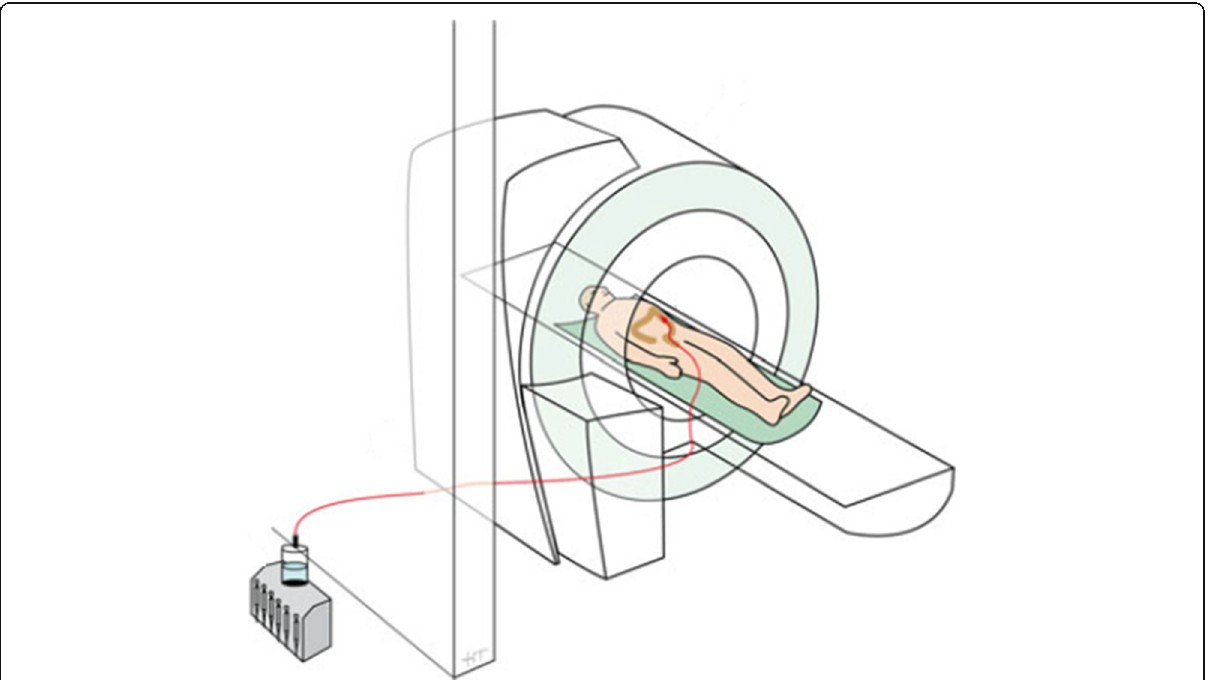
Fig. 1 Study setup simultaneous motility recordings using cine magnetic resonance imaging (MRI) and colonic manometry. Colonic manometry catheter was connected to a pneumohydraulic pump outside the MRI scanner room. Reprint with permission from